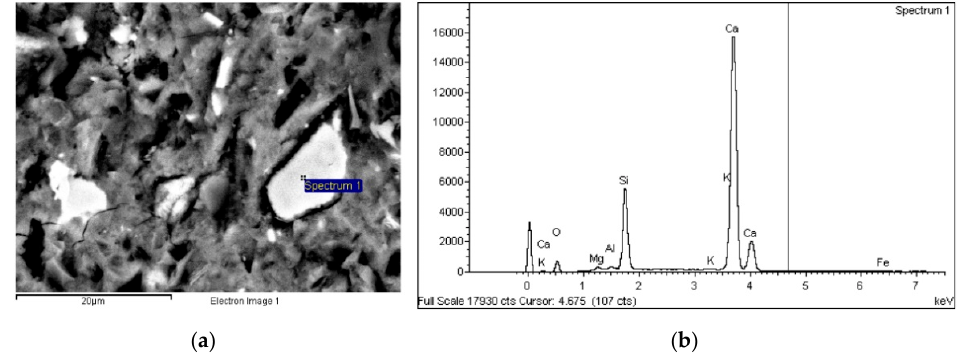
Figure 7. ( a ) BSE micrograph of UH-0F-20 (2500×) and ( b ) EDX spectrogram and chemical composition of the area identified on the micrograph.